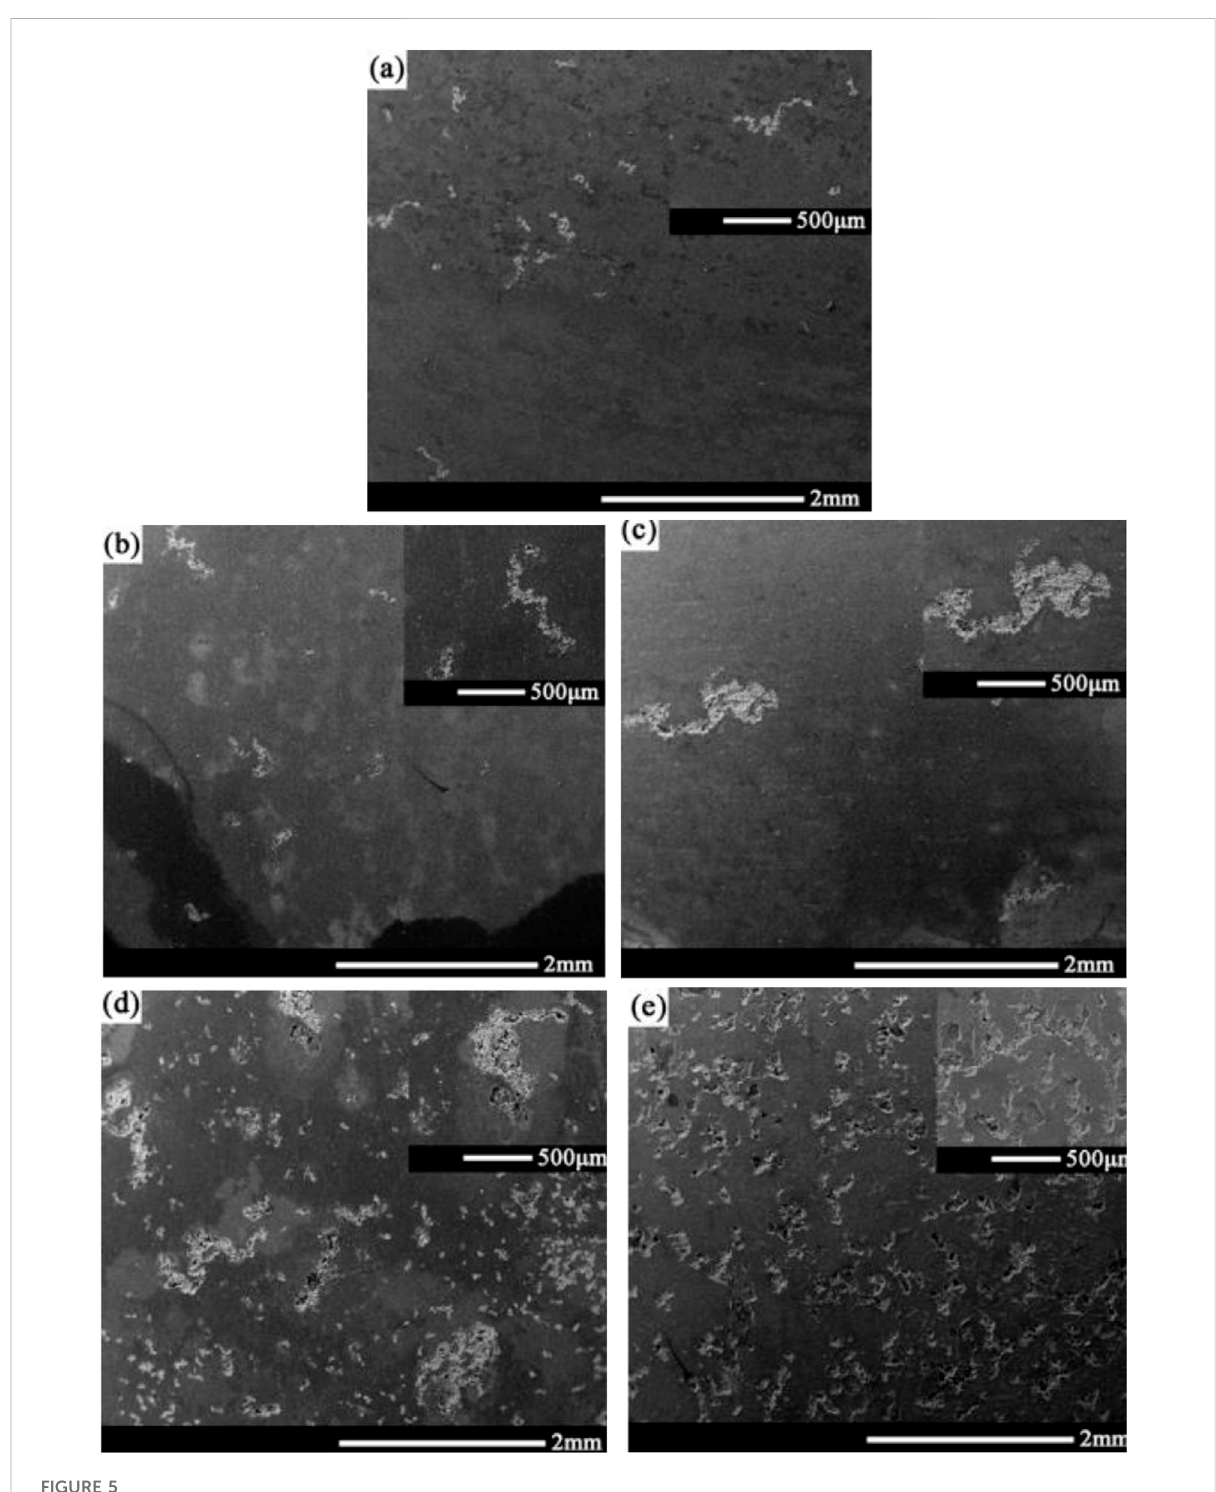
FIGURE 5 Corrosion morphology of 2060-T4 Al-Li alloy with different immersion time after removing corrosion products, (A) 6 h, (B) 24 h, (C) 72 h, (D) 168 h, (E) 720 h.